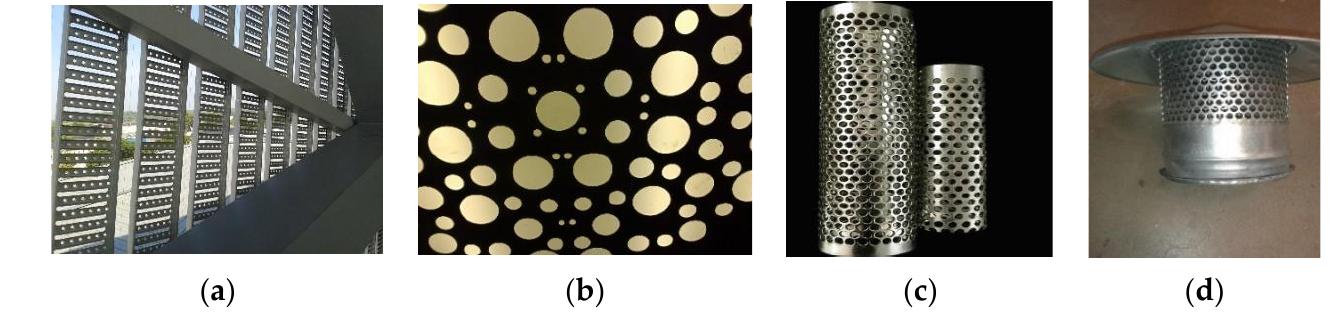
Figure 1. The use of PMMs: to reduce the level of illumination inside the room ( a ), increase the uniformity of the lighting of the elevator cabin ( b ), mute the sound ( c ) and ventilate the premises ( d ). There are many examples of the effective use of PMMs in the creation of enclosing structures for buildings and mechanical structures [15], for the manufacture of facades and decorative elements, as well as in the production of fittings for pipes and panels. PMMs are increasingly used in various interior solutions for premises and urban architecture [16,17].